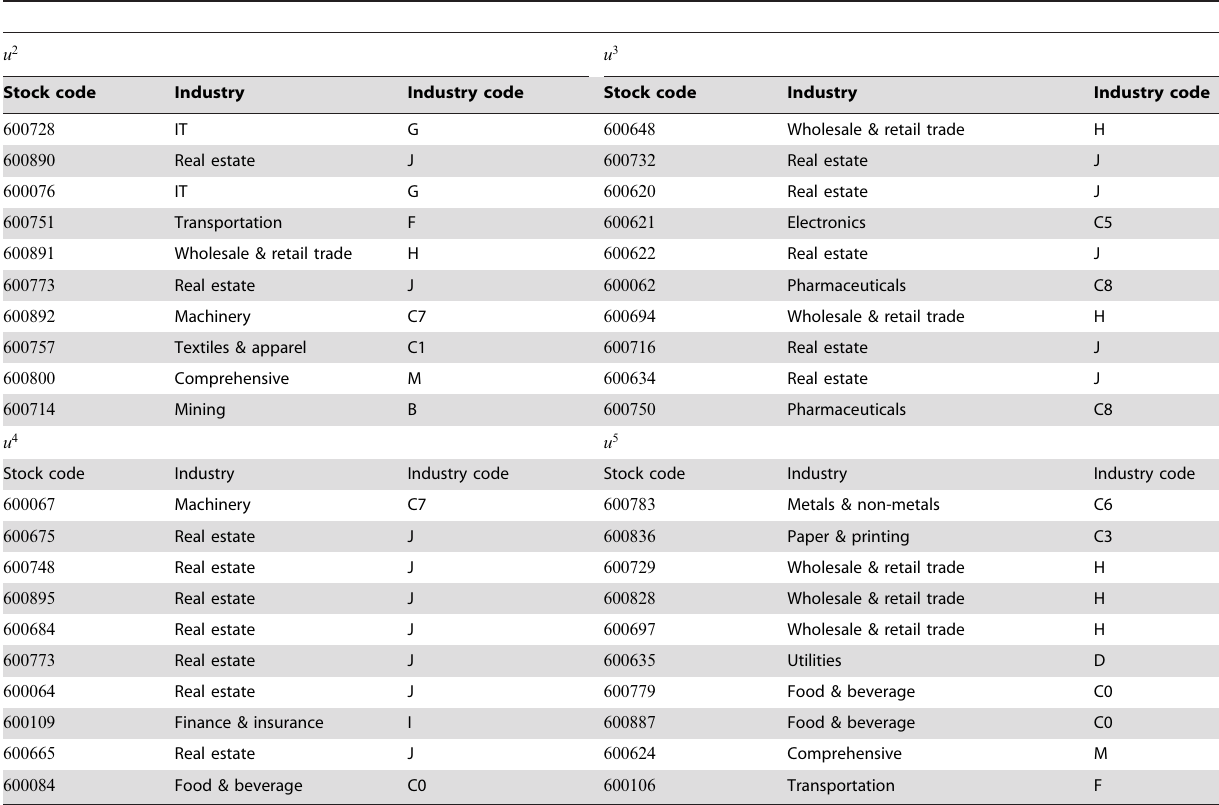
Table 5. Largest ten components of deviating eigenvectors in period from 13/01/2009 to 11/05/2010.